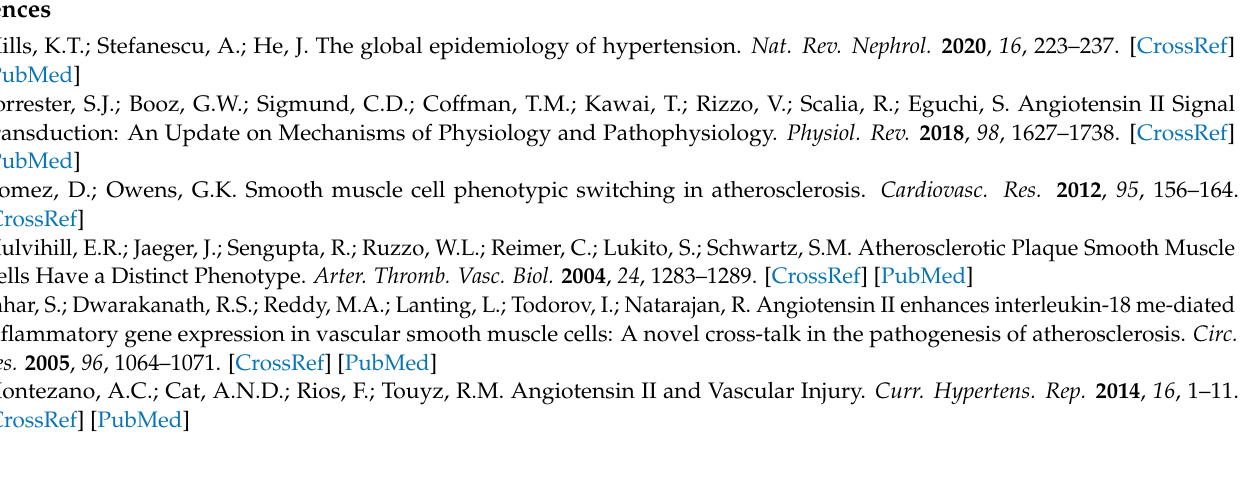
used in the study. Table S2: Complete Alivec sequence. Table S3: GapmeRs and siRNA sequences. Table S4: Antibodies used in the study and their